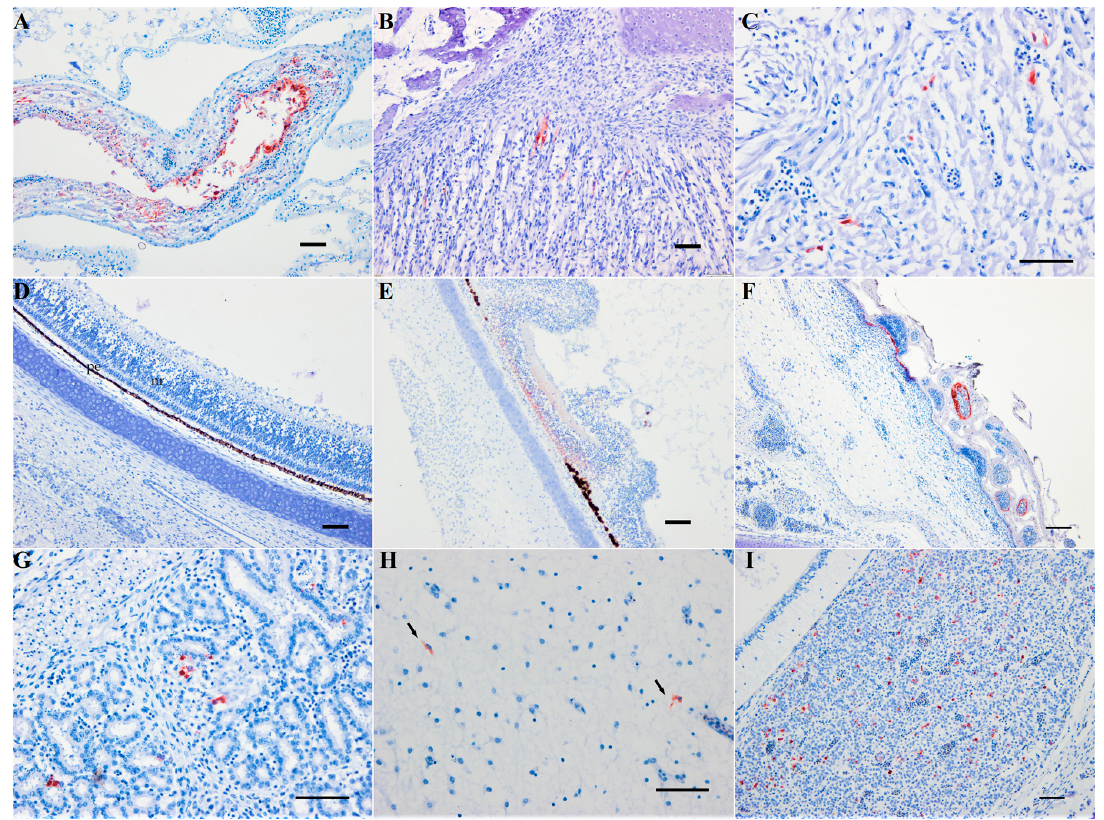
Figure 4. Immunohistochemical staining of Usutu virus antigens and chicken embryos. ( A ) Chorioallantoic membrane (CAM) on day 3 post-infection (pi); ( B ) skeletal muscle on day 3 pi; ( C ) heart on day 5 pi; ( D ) retina on day 3 of negative control; ( E ) retina on day 3 pi, degeneration of the neuronal layer with focal loss of the pigmented epithelium; ( F ) epidermis and feather follicle pulp on day 5 pi; ( G ) intestine, on day 5 pi; ( H ) brain on day 5 pi, UR-10-Tm strain; ( I ) pituitary gland on day 6 pi, USU-BE-Grivegnee/2017 strain. Mayer hematoxylin counterstain. Scale bars = 50 µm.